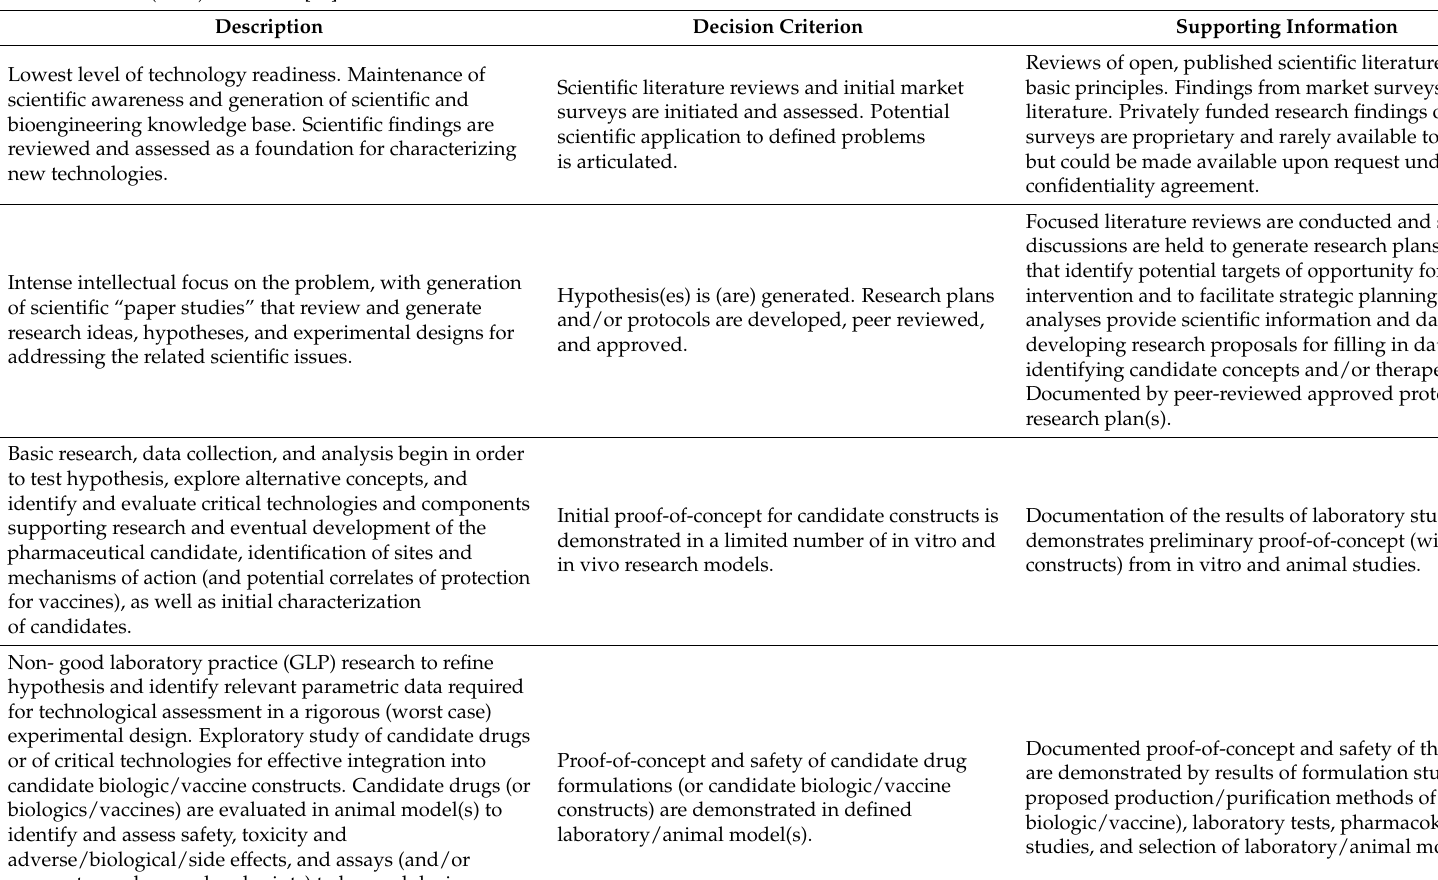
Table A1. Technical Readiness Level (TRL)